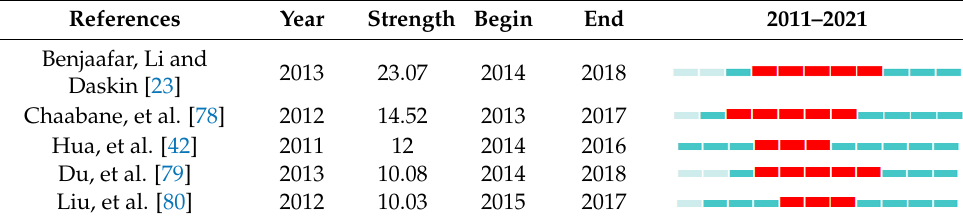
Table 8. Top 5 LCSC papers ranked by burst detection.